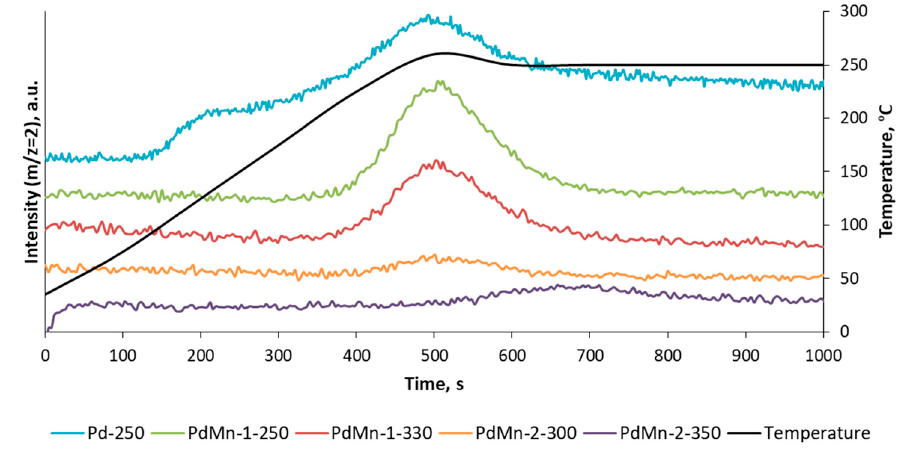
Figure 2. TPD-H 2 spectra of the samples.